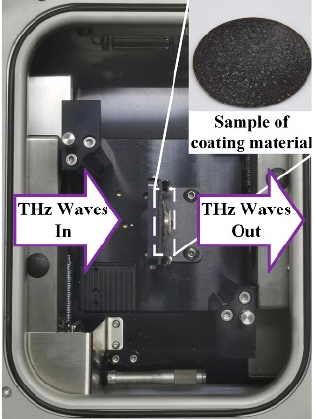
Figure 2. The transmission module of the terahertz time-domain spectroscopy system.